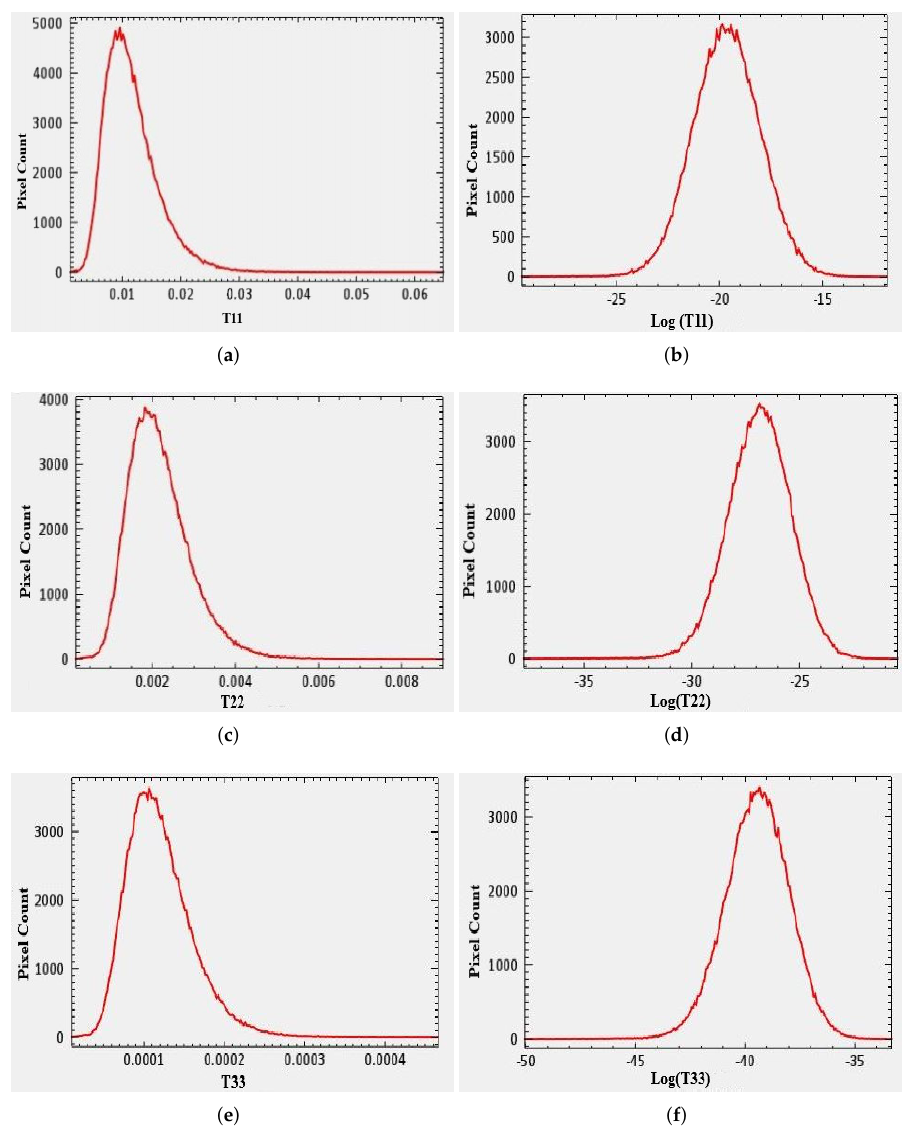
Figure 6. Histogram of elements of conventional T3 ( a ) T11, ( c ) T22, ( e ) T33 and Log transformed T3 ( b , d , f ) for a clean water